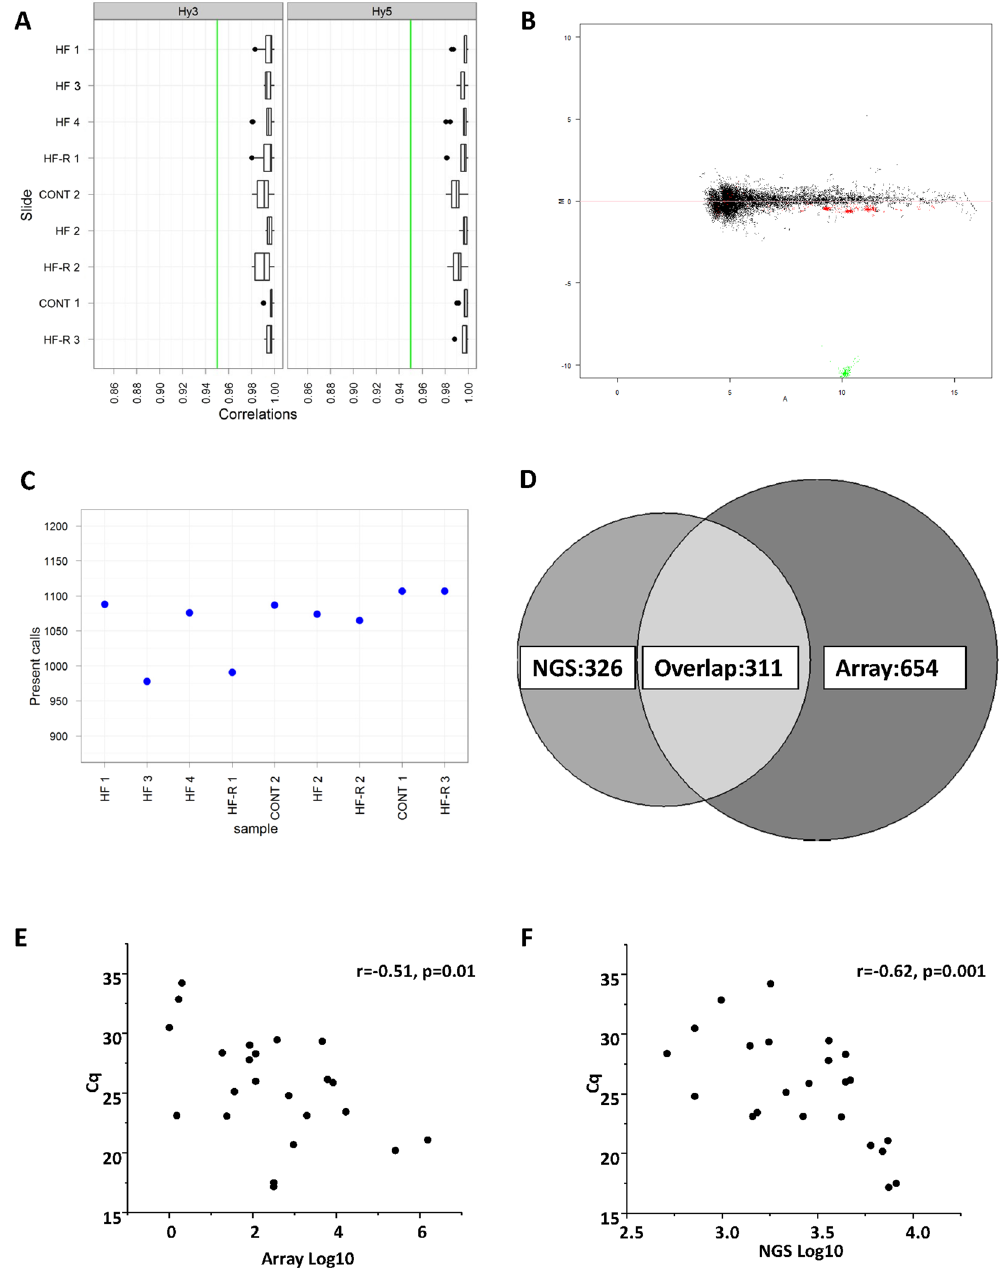
Figure 3. Analysis of microRNA microarray data from sheep left ventricular tissue. ( A ) Box plot showing the correlation R 2 of 52 spike-ins for each sample with Cy3 and Cy5 labelling. Black dots indicate outliers. ( B ) MA-plot of a representative sample after Lowess (LOcally WEighted Scatterplot Smoothing) normalization. Green: Hy3 controls, red: spike-ins, black: all other probes. ( C ) Number of miRNA in each individual sample detected above background threshold (1.2 fold above 25 th percentile). ( D ) The overlap of miRNAs detected by next generation deep sequencing (NGS) and miRNA array. ( E and F ) Correlation of array intensities with NGS counts and qPCR Cq values for 23 miRNAs. (Cont n = 2, HF n = 4, HF-R n =